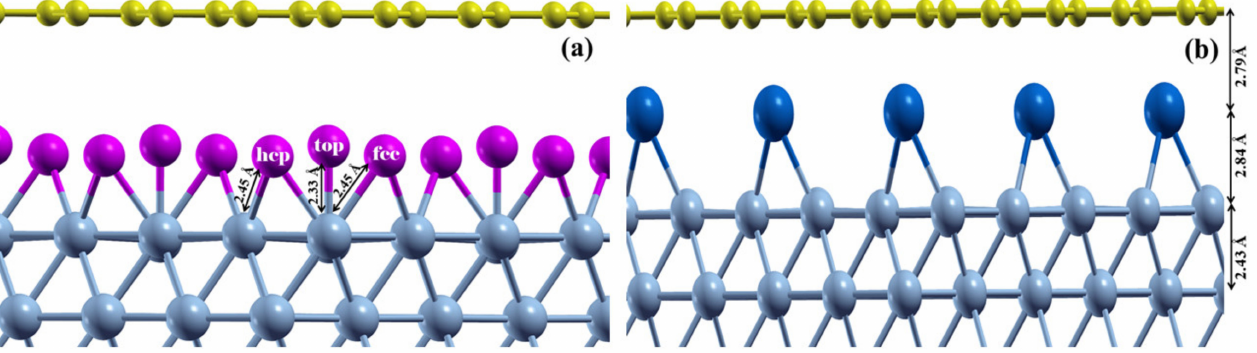
Figure 3. ( a ) Side view of Ni(111)/Al/Gr0.75 ML, the pink atoms represent Al, while the yellow atoms represent graphene sheet; ( b ) side view of Ni(111)/Na/Gr 0.25 ML, where blue atoms represent Na at the hcp